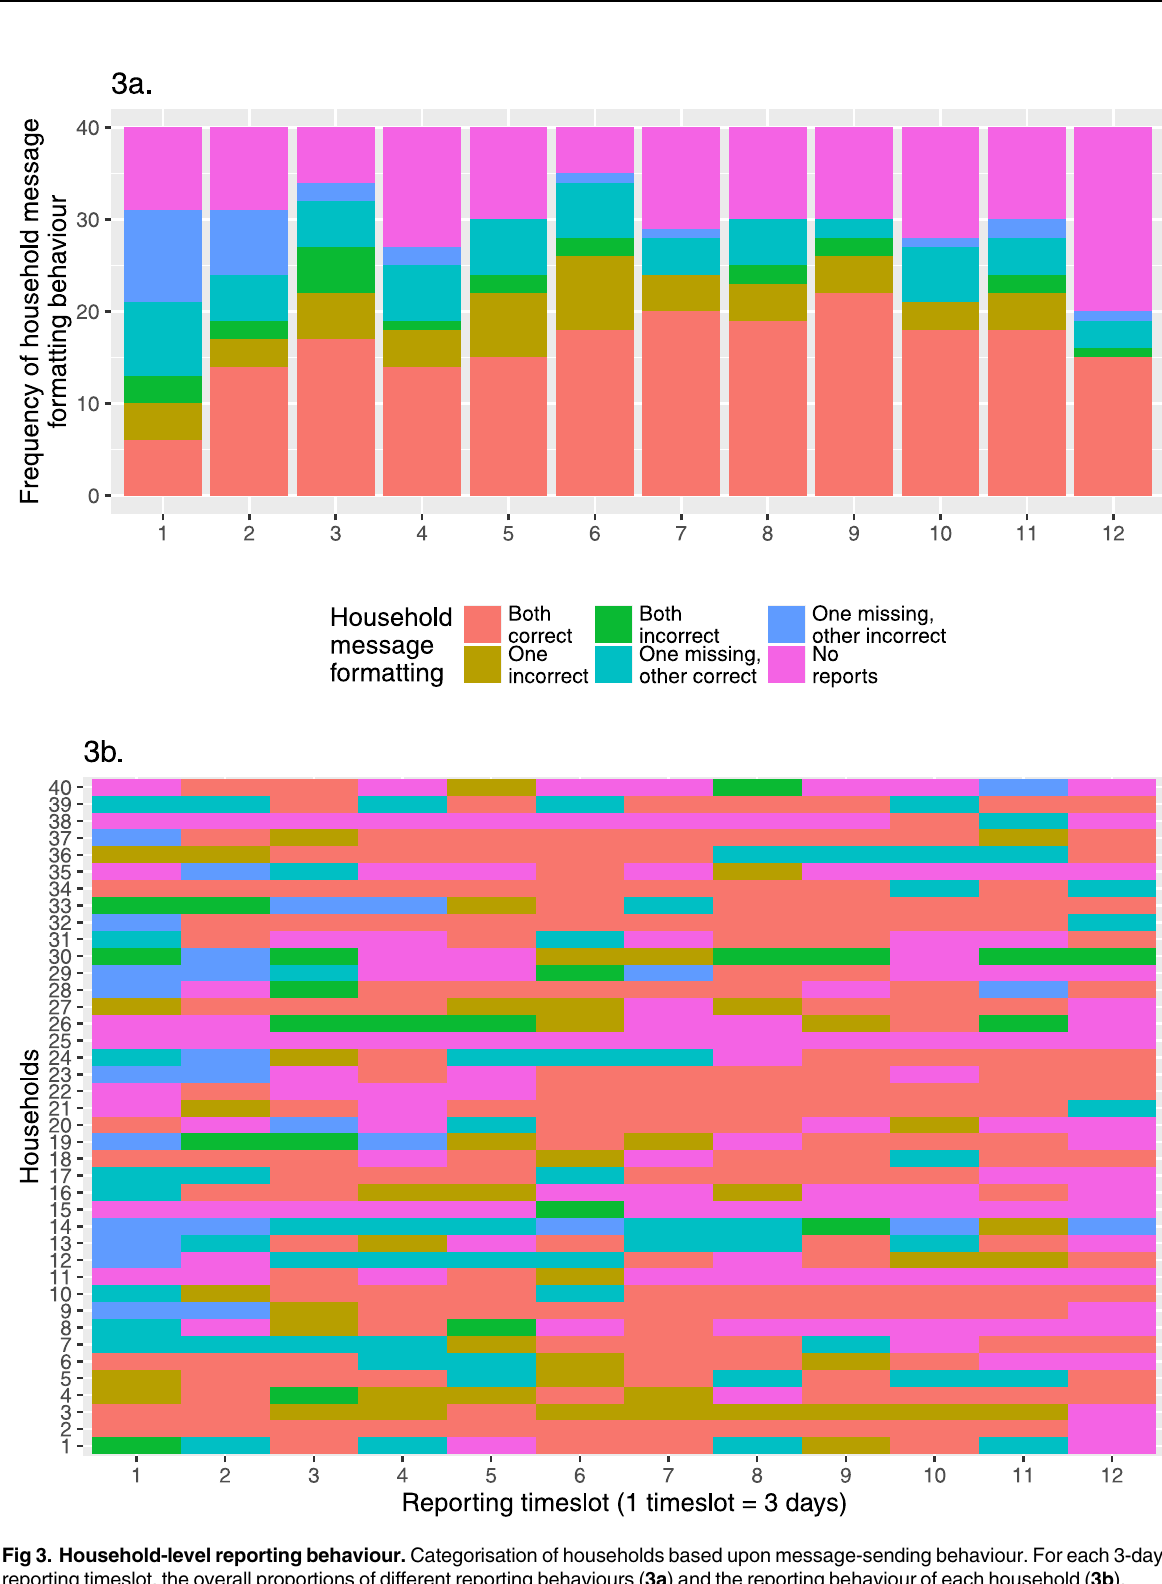
Fig 3. Household-level reporting behaviour. Categorisation of households based upon message-sending behaviour. For each 3-day reporting timeslot, the overall proportions of different reporting behaviours ( 3a ) and the reporting behaviour of each household ( 3b ).